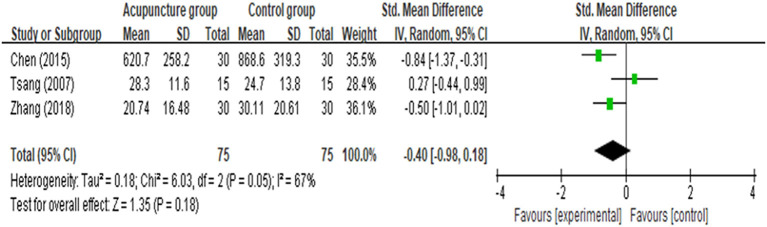
Meta-analysis and forest plot for analgesics consumption.